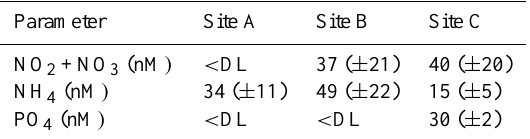
Table 1. Initial (prior to the additions) concentrations (mean ± sd of the triplicate microcosms) of mineral nutrients in the enrichments experiments at stations A, B and C. < DL: below detection